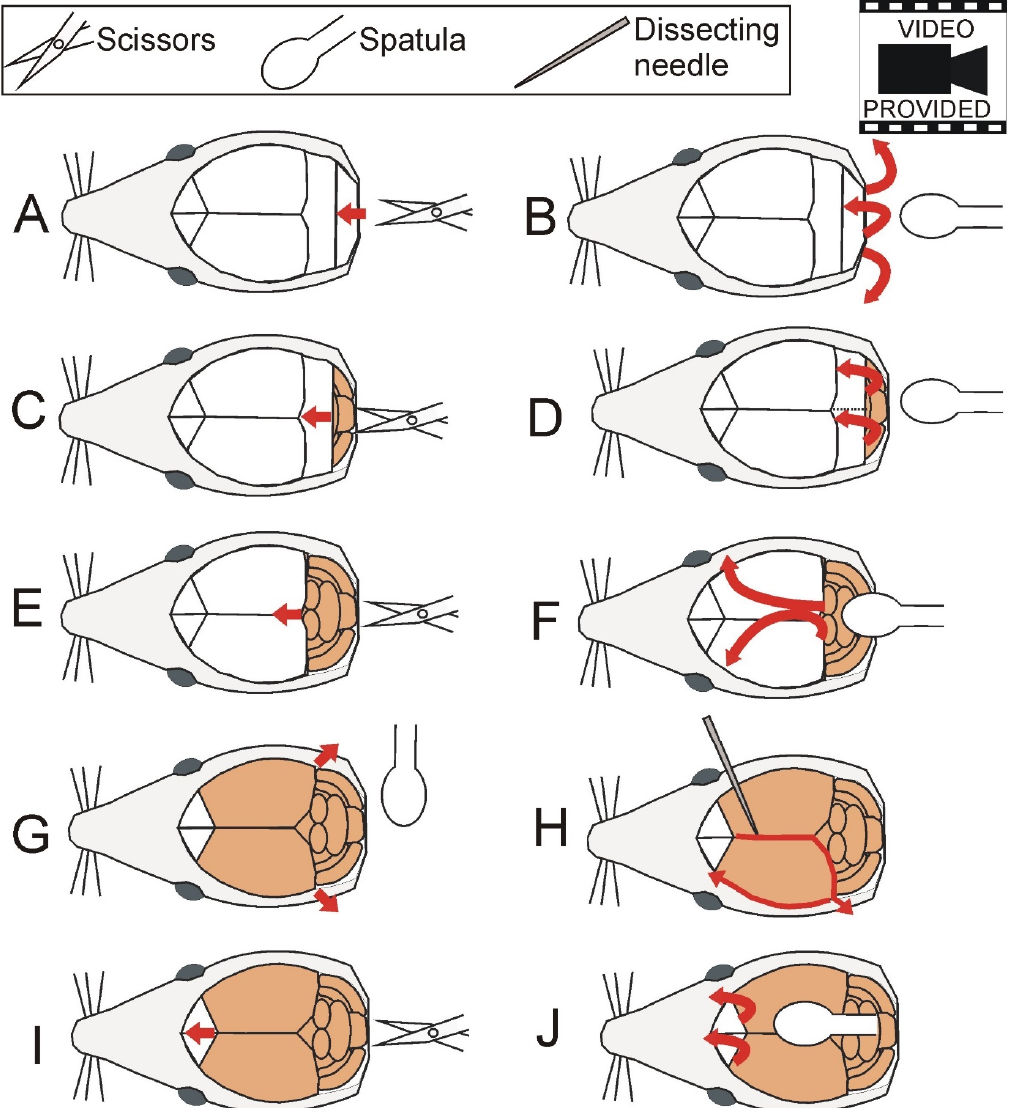
Figure 2. Removal of bones ( A – F and I – J ) and meninges ( H ). Additionally, bones on both sides